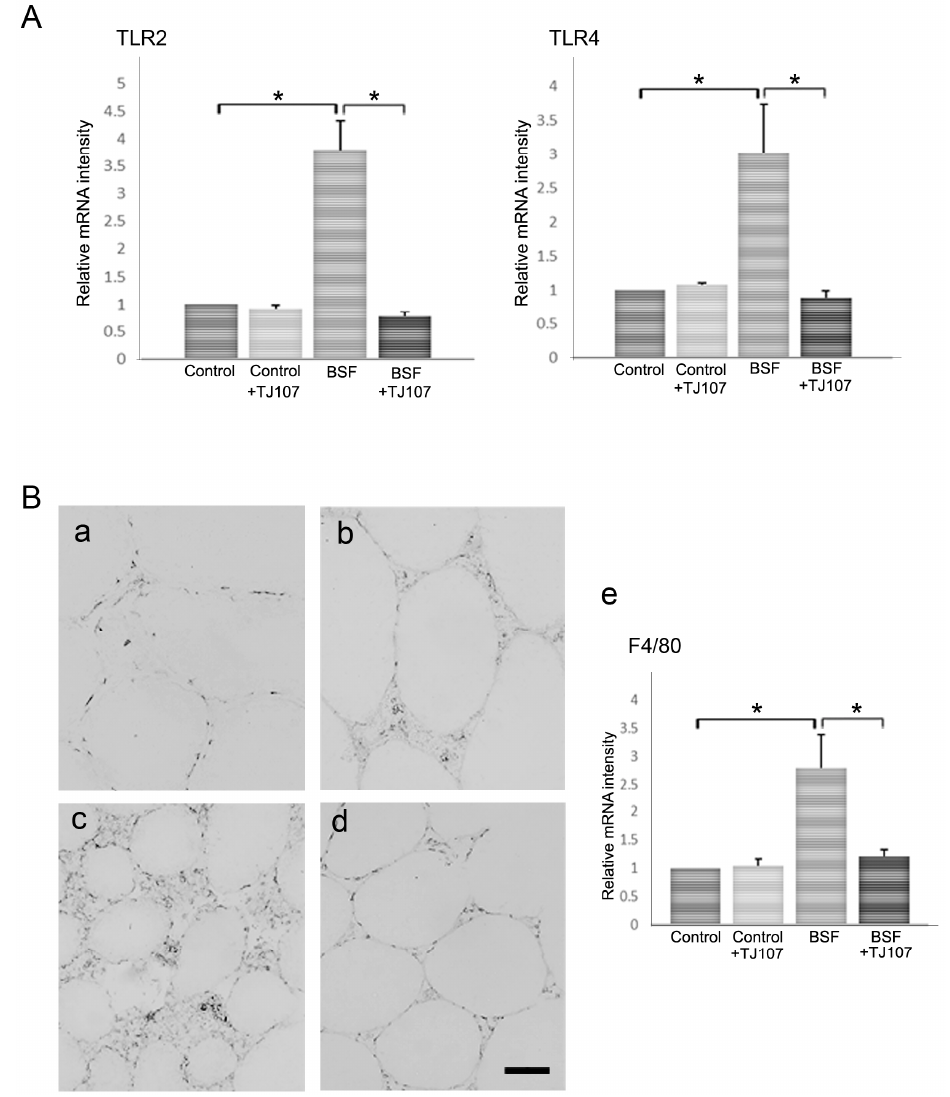
Figure 5. TLR expression and macrophage migration at day 120 in each group. A : Expressions of TLR2 and TLR4 in testicular tissues of mice from each group ( n = 10). Asterisks indicate p < 0.05. B : F4/80 antigen-positive cells in testicular sections ( n = 10) of mice from the control ( a ), control+TJ107 ( b ), BSF ( c ), and BSF+TJ107 ( d ) groups. Many macrophages are seen infiltrating the interstitium around the atrophic seminiferous tubules in the BSF group ( c ). Bar = 20 µm. ( e ) Expression of the macrophage marker gene in testicular tissues of mice from each group ( n = 10). Asterisks indicate p < 0.05.